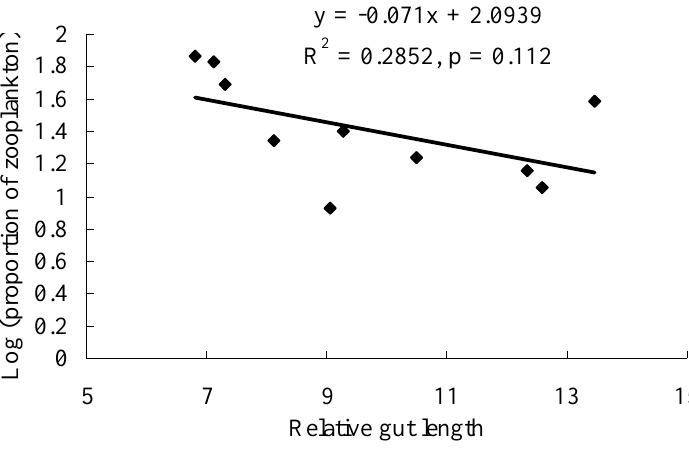
y = -0.071x + 2.0939 R 2 = 0.2852, p = 0.112